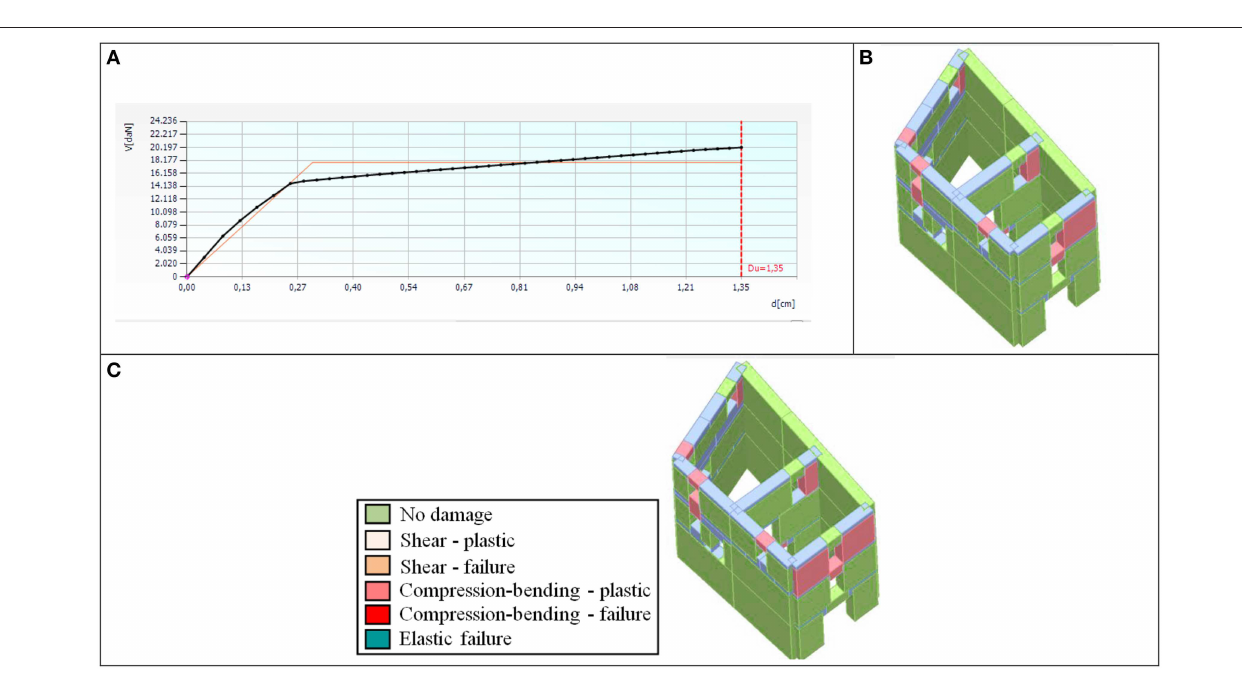
On the other hand, the curves of these S.U. have been directly obtained from the analysis results on the global cluster by considering their interaction with other units